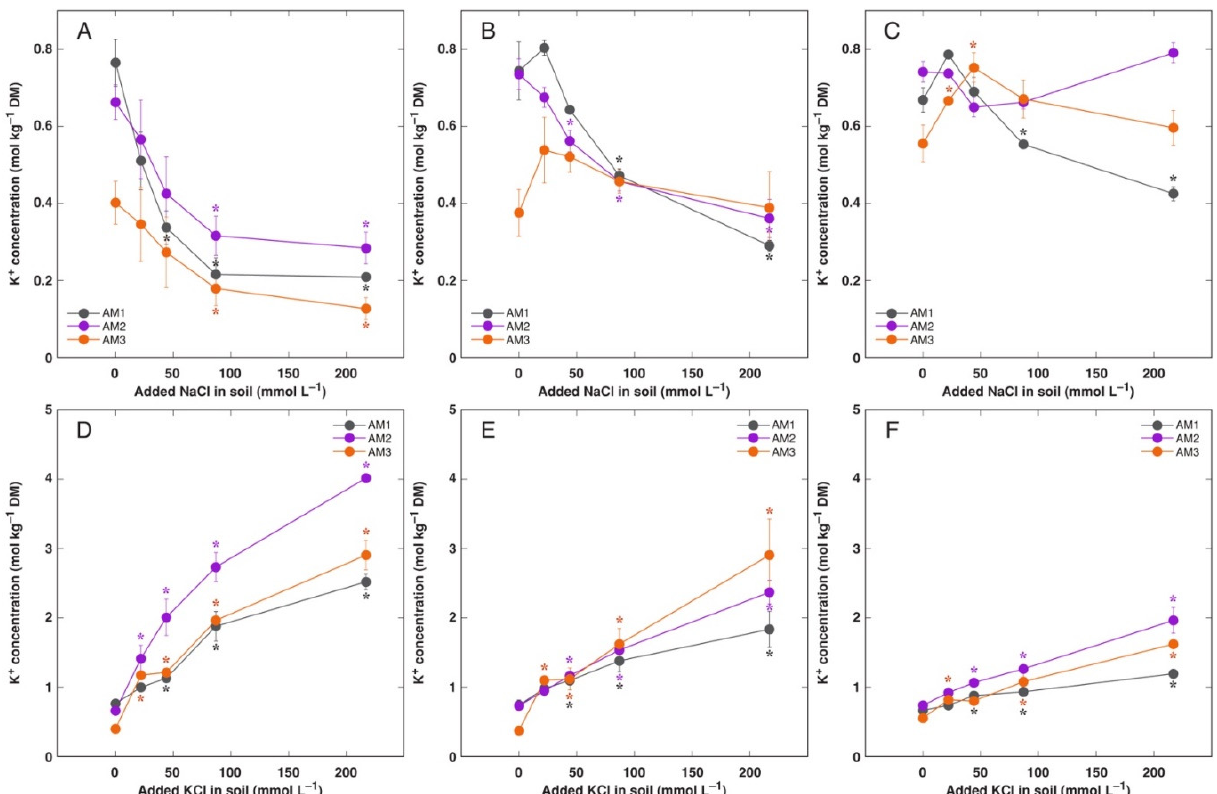
Figure 6. Effect of added NaCl concentration in soil on accumulation of Na + in old leaves ( A ), new leaves ( B ) and flowers ( C ) of Armeria maritima plants from different accessions after 7–8 weeks of cultivation. DM, dry mass. Data are means ± SE from 3 replicates. Asterisks of respective color indi- cate statistically significant differences ( p < 0.05) from control.